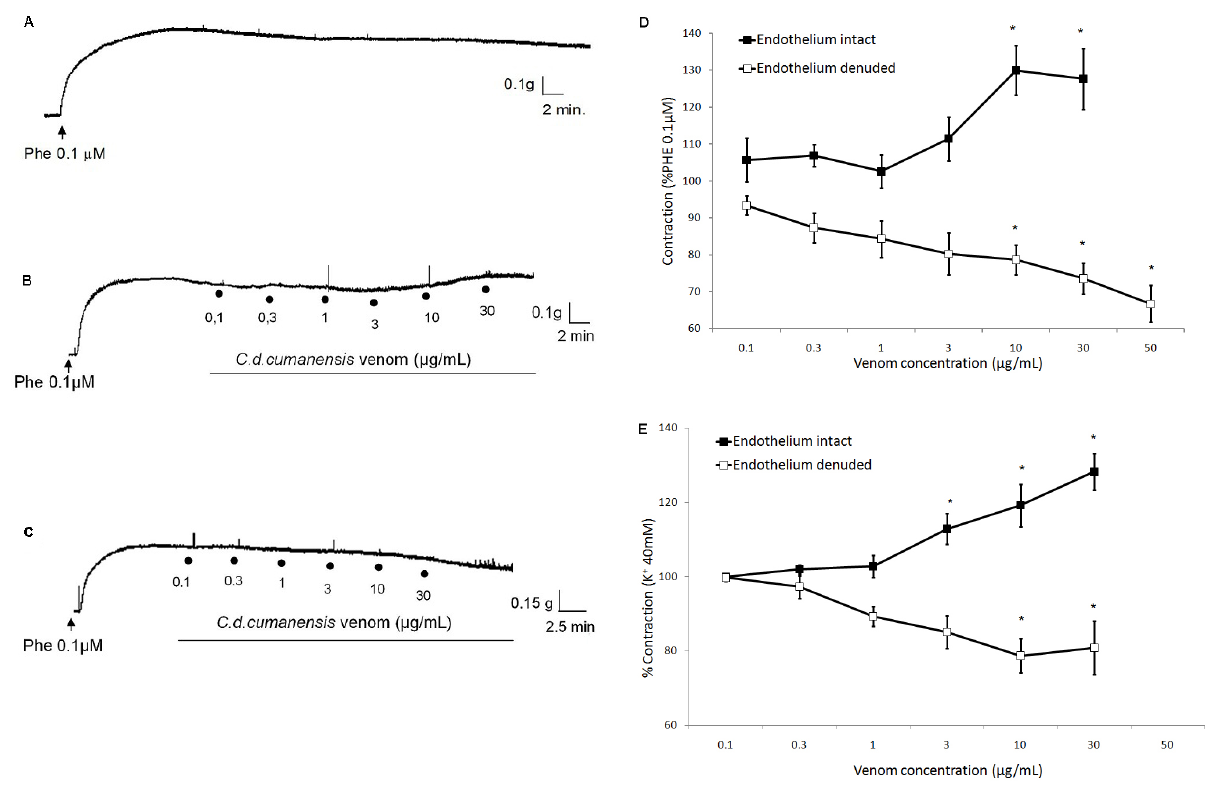
Figure 6. ( A ) Typical trace illustrating the timed control of a sustained PHE-induced contraction in aortic rings maintained in the presence of 0.1 µM PHE for 55 minutes. Typical traces of a concentration-response curve of the C. d. cumanensis venom on ( B ) endothelium-intact or ( C ) endothelium-denuded aortic rings pre-contracted with 0.1 µM PHE. Note that the vascular relaxation induced by 1 µM ACh added during the steady state of a PHE-elicited contraction was observed only in endothelium-intact preparations. ( D ) Concentration-response curve depicting the effects of C. d. cumanensis venom on isolated aortic rings in the presence ( l : 0.1-30 µg/mL) and absence (Δ: 0.1-50 µg/mL) of endothelium, and on phenylephrine-induced contraction (PHE, 1 µM). ( E ) Concentration-response curve depicting the effects of C. d. cumanensis venom on isolated aortic rings in the presence ( l : 0.1-30 µg/mL) and absence (Δ: 0.1-50 µg/mL) of endothelium, and on potassium-induced contraction (K + , 40 mM). Data are expressed as means ± SEM, one-way ANOVA, Holm-Sidak post-test, * p <0.01, compared with corresponding baseline